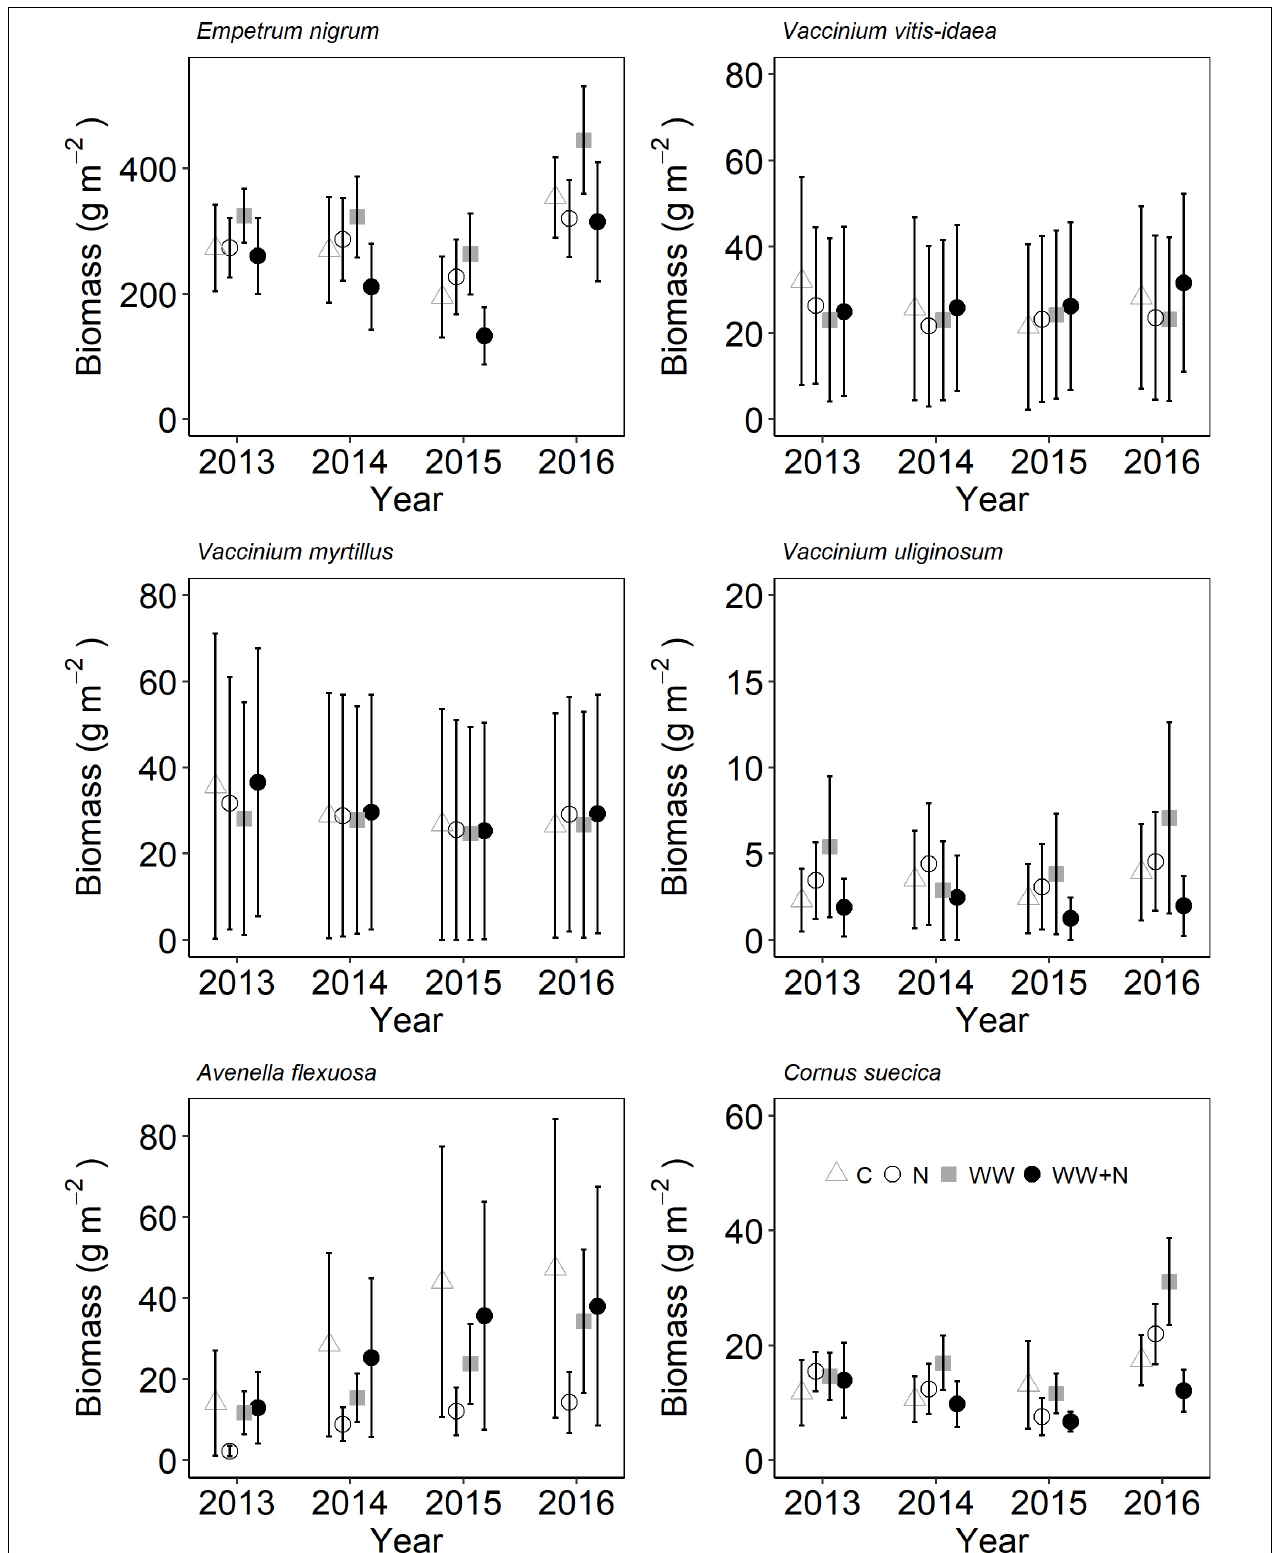
FIGURE 3 | Species-specific plant biomass following extreme winter warming (WW) and nitrogen (N) additions in sub-arctic Norway. Data points are mean of n = 6 plots with SE as error bars.